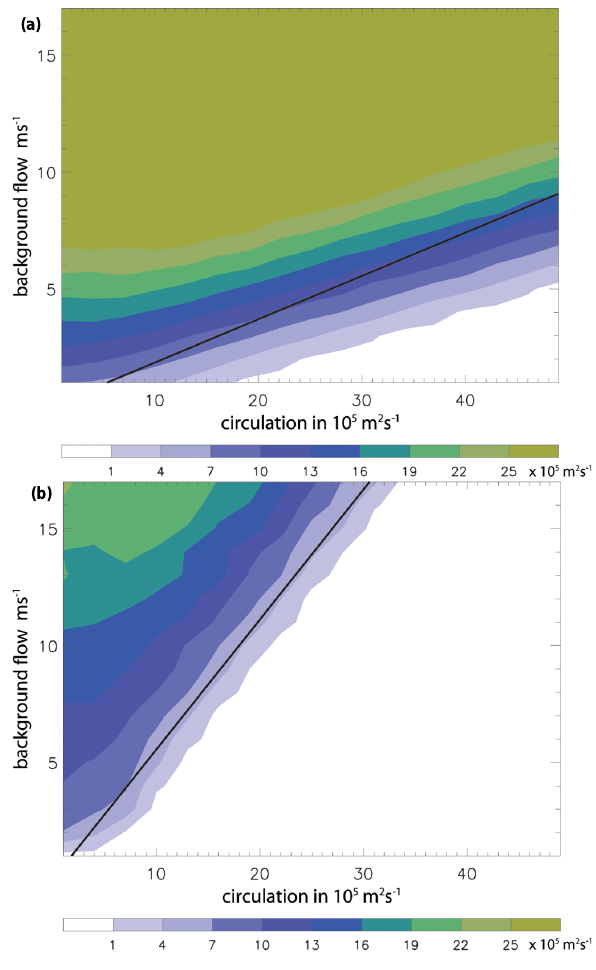
Fig. 9. Inflow rate of environmental air, F env , (shaded) at the ra- Journalname www.jn.net dius of 150km indicating rain band interaction (a) and at 50km indicating eyewall interaction (b) as a function of circulation 0 (ab- scissa) and storm-relative environmental flow U (ordinate). Val- ues are calculated for the point vortex with centered mass sink ( D = − 1 . 5 × 10 5 m 2 s − 1 ). The solid line denotes the values of 0 and U for which the closest distance of the dividing streamline from the center is at the rain band (a) and eyewall (b) radius, respectively (cf. Fig. 8).